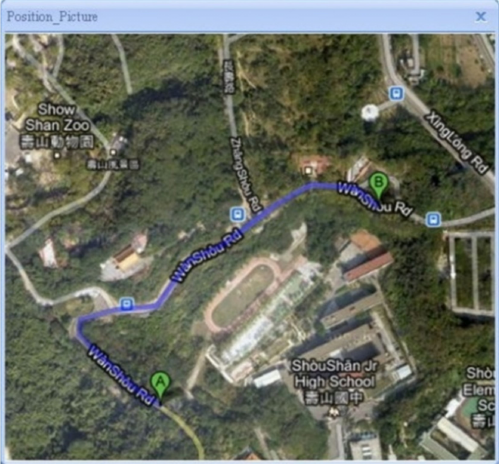
Figure 6. Google Map used for candidate location evaluation.